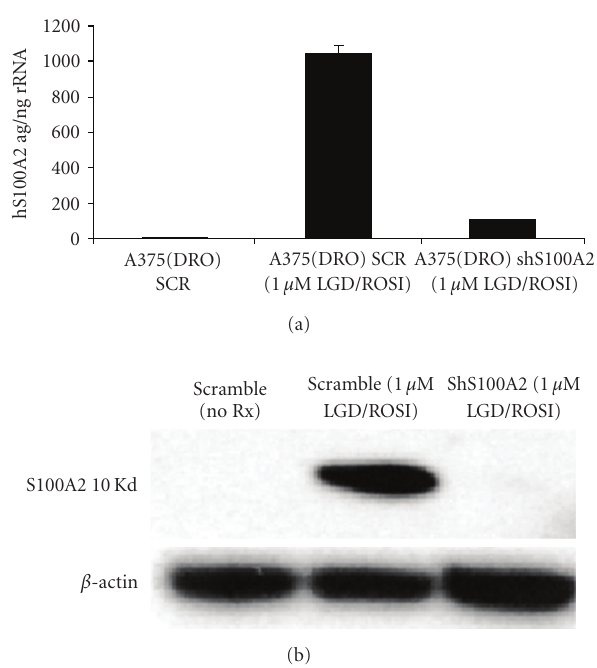
Figure 4: shS100A2 decreases S100A2 mRNA and protein in A375(DRO) cells. qRT-PCR and Western blot of S100A2. (a) One microgram of total RNA was used for the S100A2 quantita- tive reverse transcription-PCR analysis (ABIPRISM7700; Perkin- Elmer), and absolute values were derived from a standard curve using a known amount of sense strand RNA (ag, attograms of sense strand RNA). Isoform RNA was normalized to total input RNA (18s rRNA measured from 1ng of total RNA). (b) 60 μ g of nuclear protein extract from A375(DRO), the SCR shRNA infected control cell, and shS100A2 infected cells. Proteins were size-separated on a 10% SDS-PAGE gel and transferred to nitrocellulose. The blot was blocked with 10% nonfat milk and incubated with S100A2 primary antibody (sc Y20) and then secondary antibody with antimouse IgG conjugated to horse-radish peroxidase as previously described. β - actin was measured as a loading control.